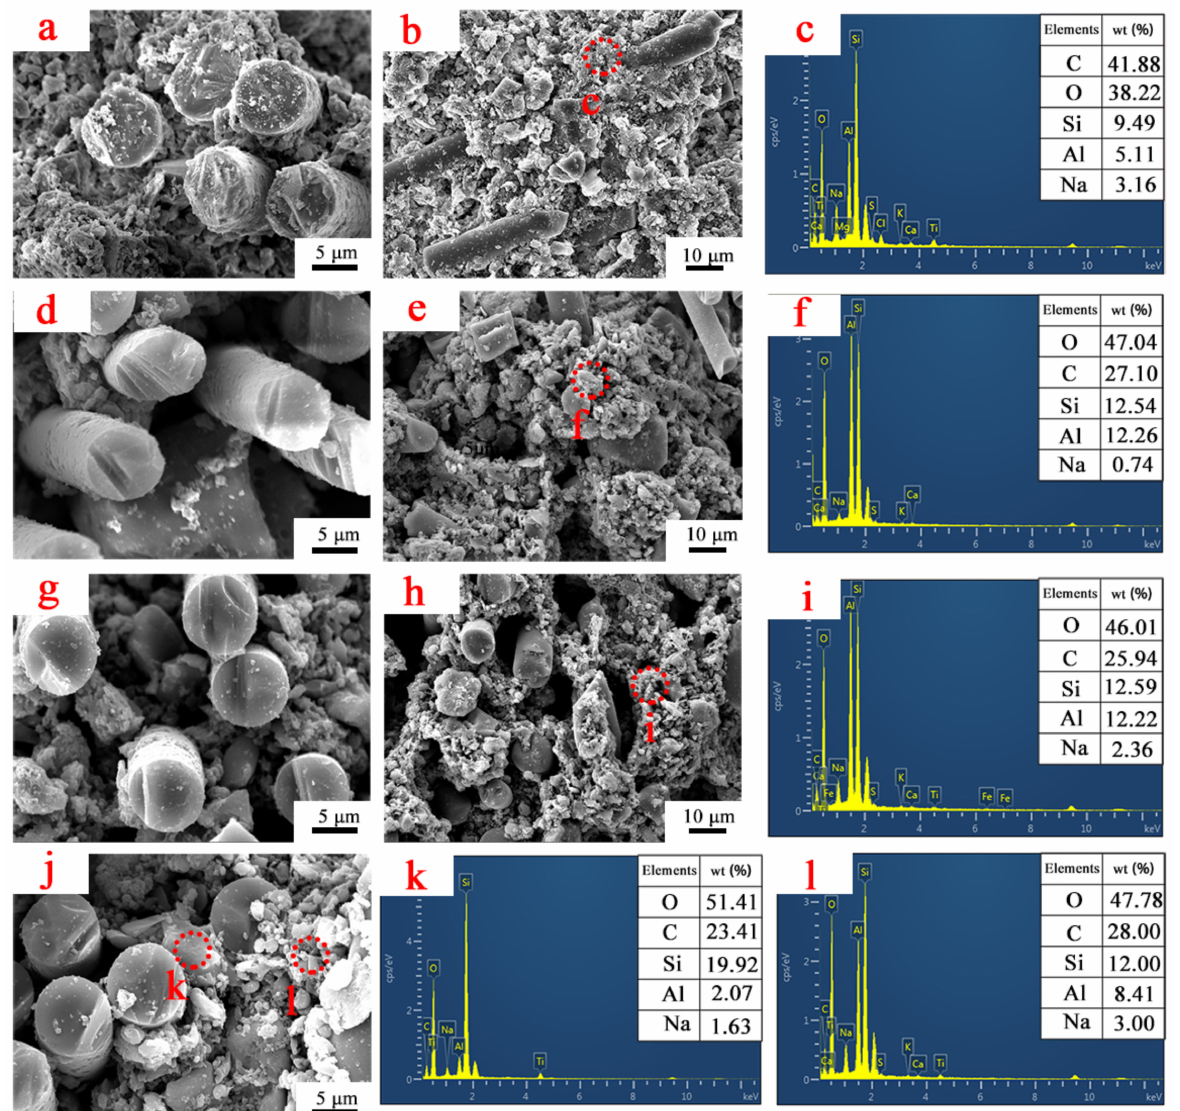
Figure 8. The micromorphology and element distribution of sample R4 after static ablation at differ- ent temperatures: ( a , b ) micromorphology of R4 after static ablation at 400 ◦ C, ( c ) element distribution; ( d , e ) micromorphology of R4 after static ablation at 600 ◦ C, ( f ) element distribution; ( g , h ) micromor- phology of R4 after static ablation at 800 ◦ C, ( i ) element distribution; ( j ) micromorphology of R4 after static ablation at 1000 ◦ C, ( k , l ) element